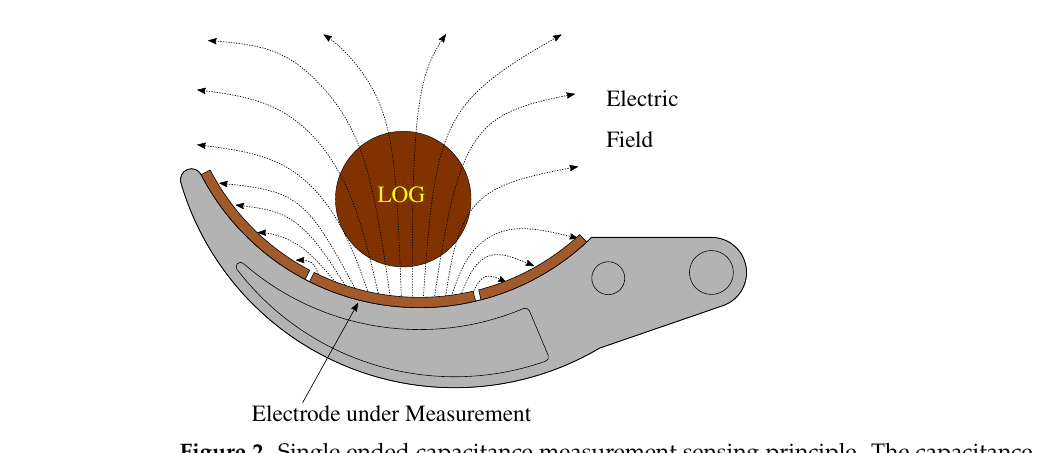
Figure 2. Single ended capacitance measurement sensing principle. The capacitance between the transmitter electrode and the environment is affected in presence of nearby materials and their dielectric properties.